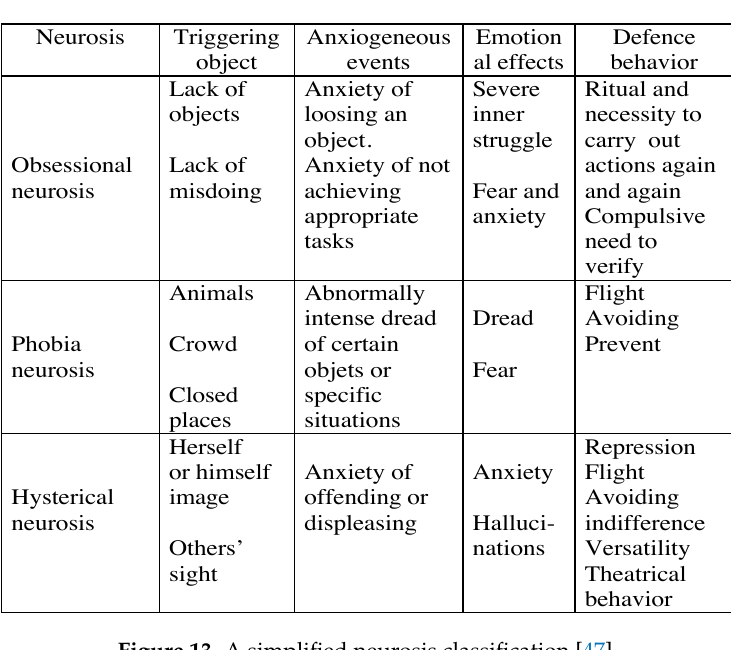
Table 2. A generic model of the neurotic personality Figure 12. A generic model of neurotic personality [47].